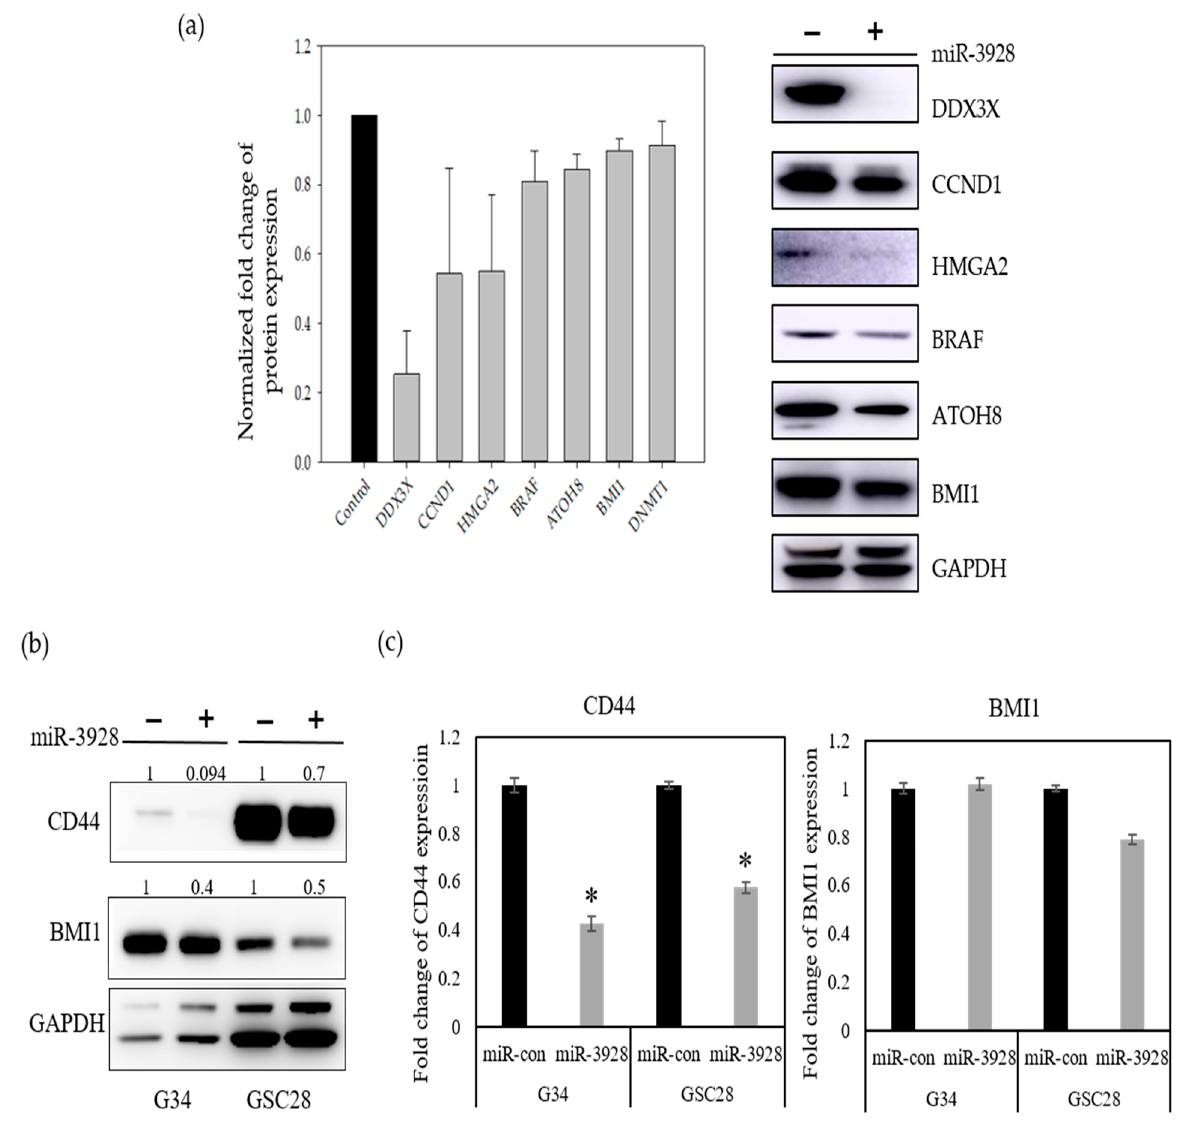
Figure 7. miR-3928 inhibits the expression of various oncogenes. ( a ) GBM cell lines A172 and U87 were transfected with either miR-3928 or miRNA scrambled control. Cells were lysed and subjected to immunoblotting for oncogenic proteins predicted to be targeted by miR-3928. Immunoblot band intensities were quantified and averaged. ( b ) GSCs were transfected with miR-3928 or scrambled controls and subjected to immunoblotting for CD44 and BMI1. ( c ) GSCs were transfected with miR-3928 or scrambled controls and CD44 and BMI1 mRNA levels were measured with qRT-PCR normalized to 18sr in the same cells. * = p < 0.05 .